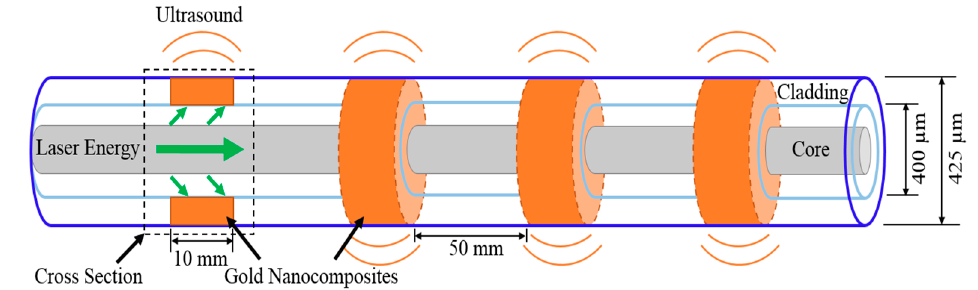
Figure 2. The schematic of distributed photoacoustic sensor.